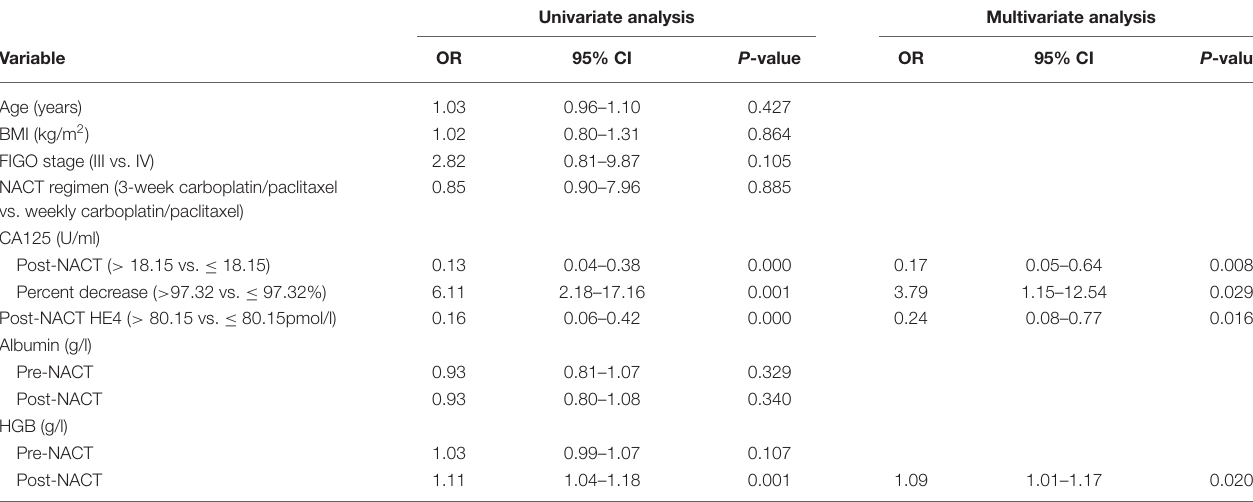
TABLE 3 | Logistic regression analysis of factors predicting chemotherapy response score 3 following neoadjuvant chemotherapy. Univariate analysis Multivariate